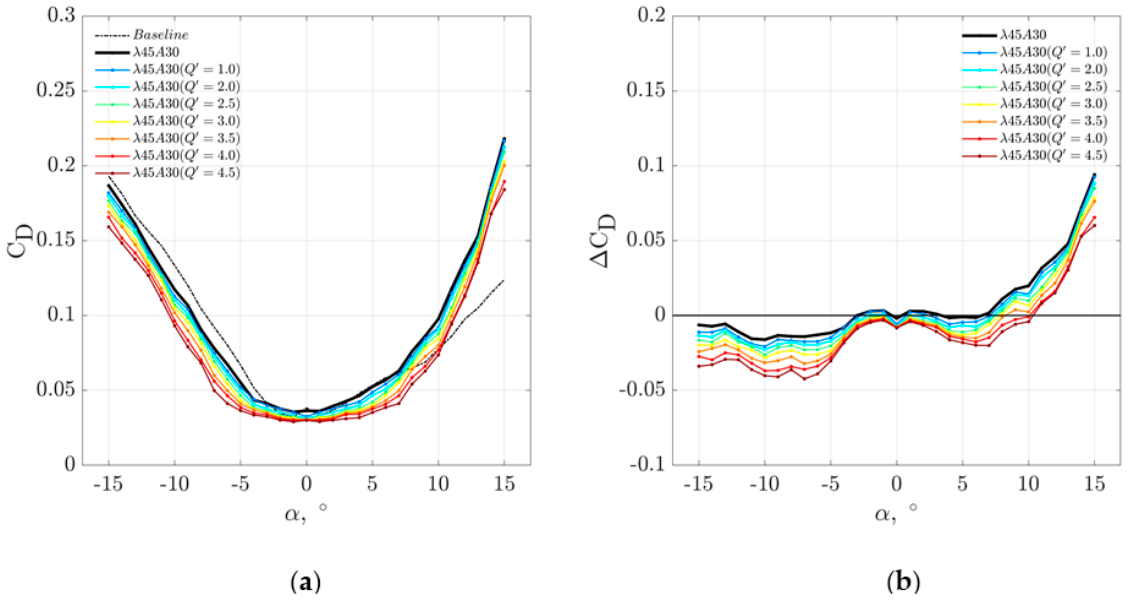
Figure 13. Comparison of the ( a ) C D as a function of α produced by the baseline and hybrid ( λ 45 A 30 + blowing Q ‘ ) leading edge device at U = 25 ms − 1 . The leading edge blowing range covers 0.0 (serration only) ≤ Q ‘ ≤ 4.5 L/min, and ( b ) The corresponding Δ C D as a function of α , where Δ C D is the difference in C D between the hybrid ( λ 45 A 30 + Q ‘ = 0.0–4.50 L/min) and the baseline.